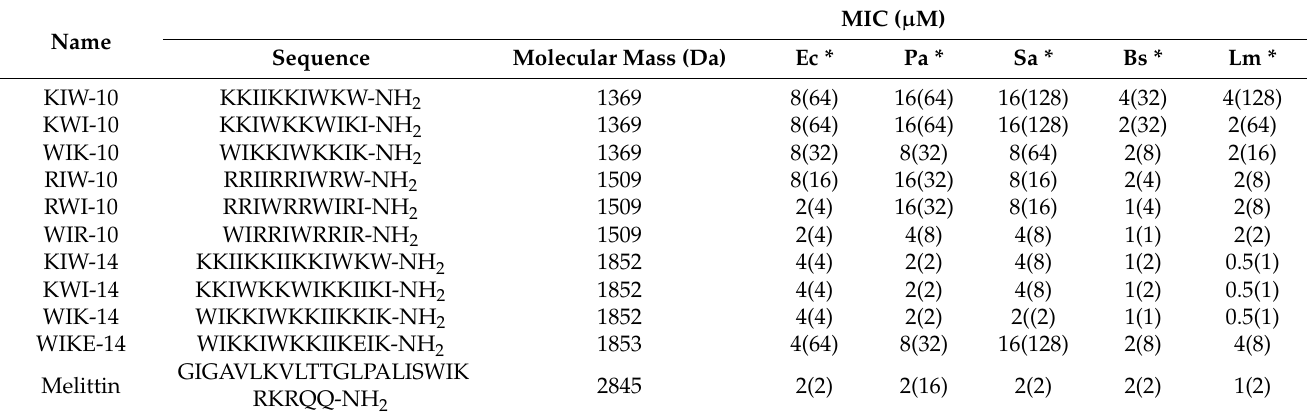
Table 1. Sequences and antibacterial activities of the designed peptides.